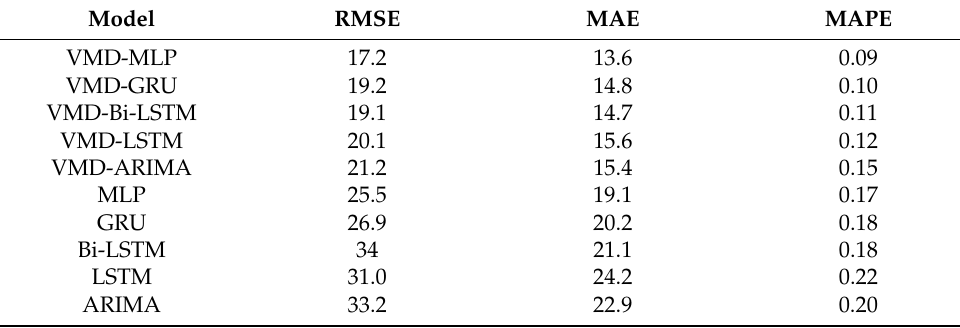
Table 6. Comparison of the proposed models and